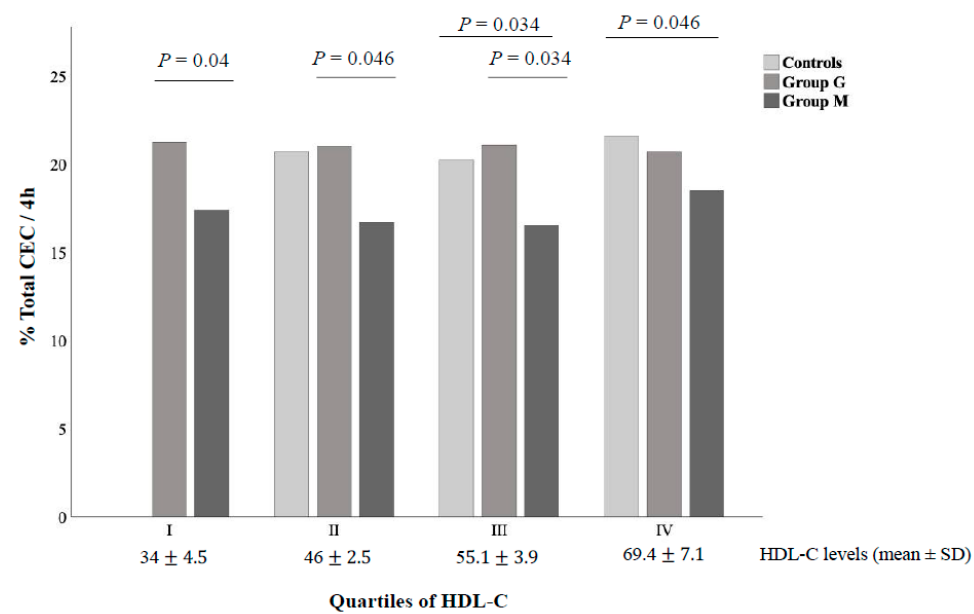
Figure 3. Whole CEC in study groups according to HDL-C levels. The figure shows differences in the whole cholesterol efflux capacity between groups according to quartiles of HDL-C. There were significant differences in efflux between all pairs with the same or similar HDL-C as determined by Mann-Whitney test. No Controls were present in the first HDL quartile.